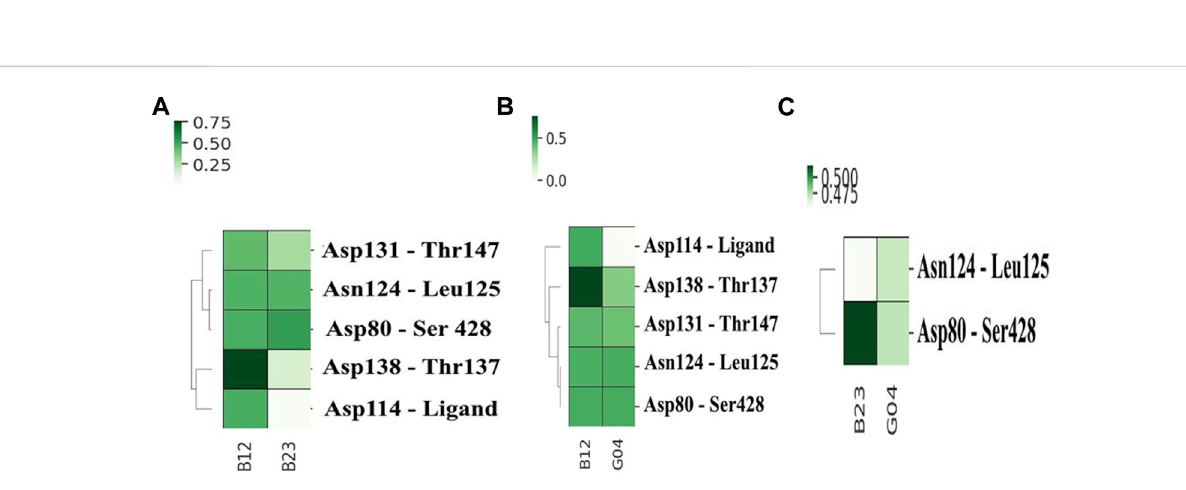
FIGURE 8 Heatmapcontactscomparinghydrogenbondformationfrequenciesin (A) B12andB23, (B) B12andG04,and (C) B23andG04intheactivesite of the protein. The related HBN is also shown in each